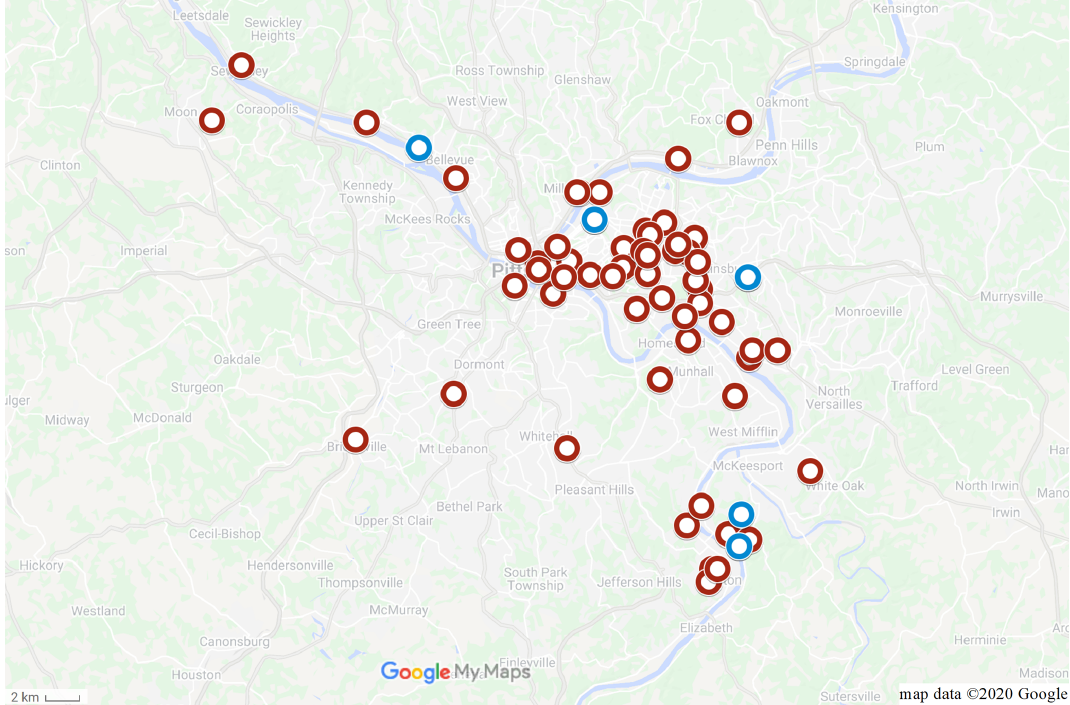
Figure 2. Map of ground sites in the Pittsburgh area. Blue dots represent sites of regulatory-grade monitors used in the analysis, while red dots represent sites of low-cost sensor deployments. Background map obtained from http://maps.google.com (last access: 22 June 2020); map data ©2020 Google. Note the scale in the lower left corner. Also note that the pair of regulatory sites in the southeast of the map are located adjacent to a major industrial source (a coking plant for steel production), while the regulatory site to the northwest of the map is located adjacent to another industrial source (a chemical